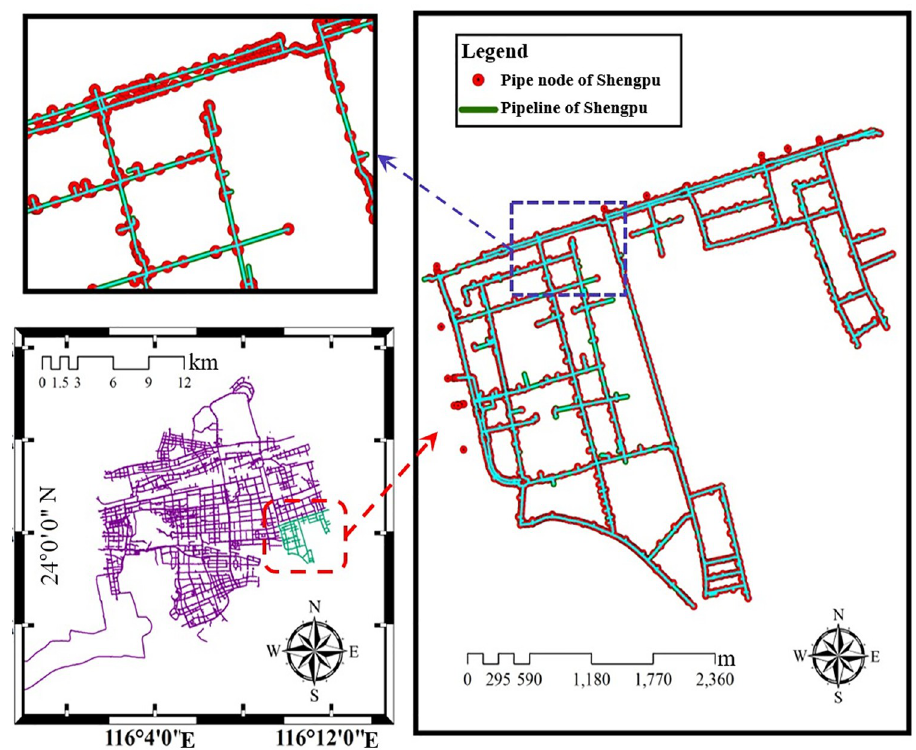
Fig 11. Nodes of water supply network in Shengpu subregion of Suzhou Industrial Park. (Republished under a CC BY license, with permission from Suzhou Industrial Park Qingyuan Huayan Water Co. LTD, original copyright 2019).